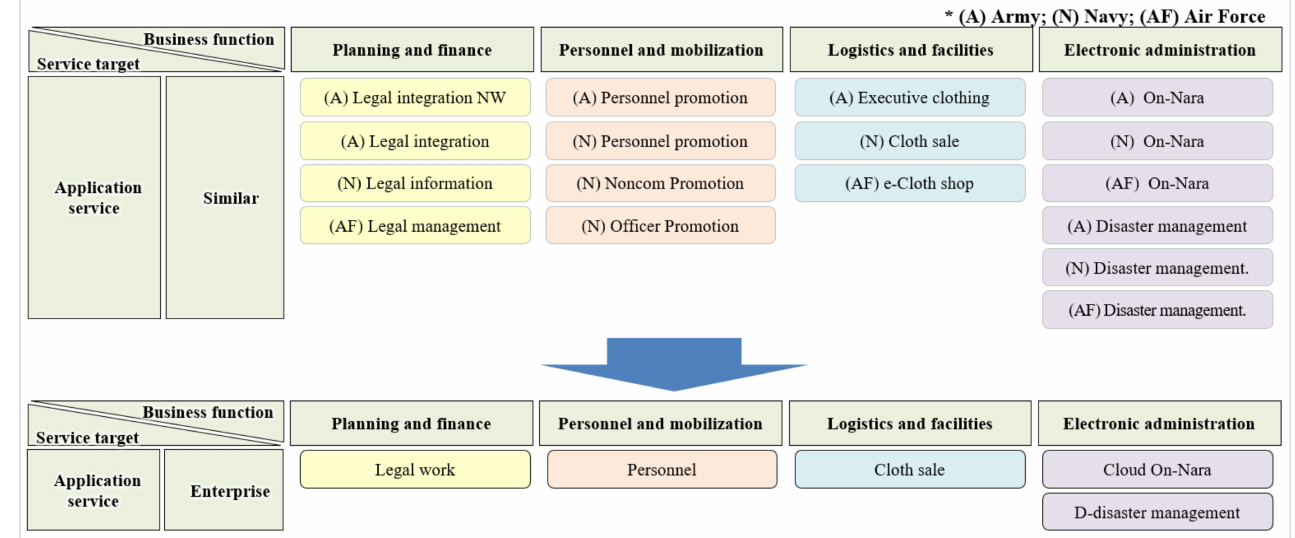
Figure 5. Cases of integration of similar services between